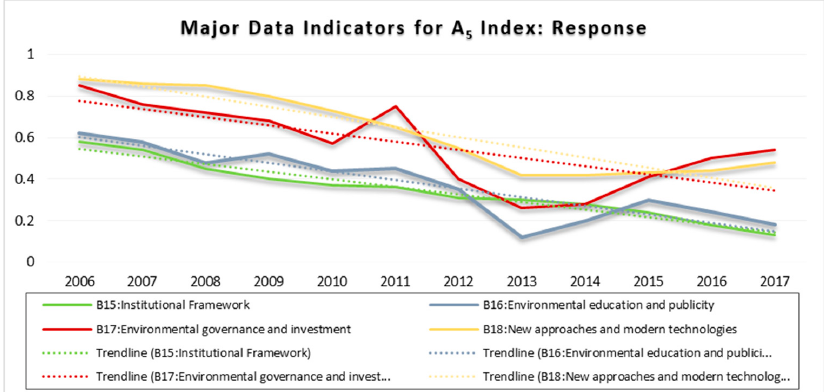
Figure 6. Major Data Indicators for the Response Index (A 5 ).